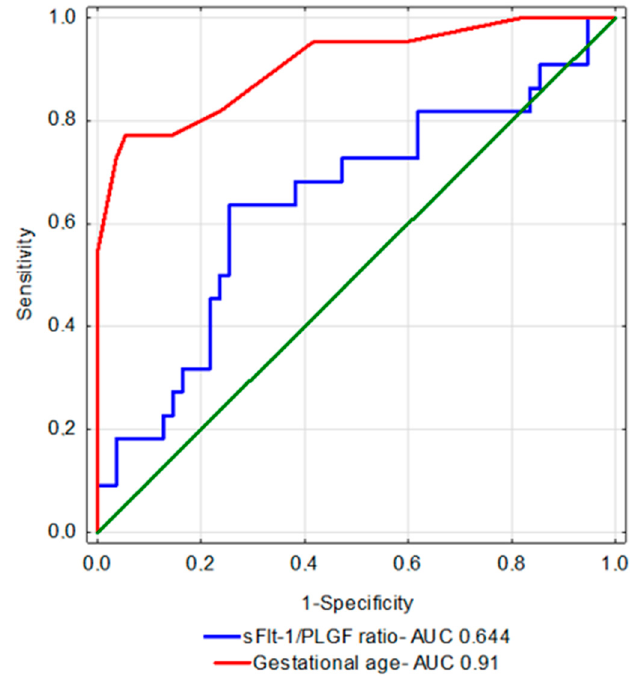
Figure 1. ROC curves for the selected parameters. Table 3 contains a comparison between the infants’ perinatal outcomes and the neo- natal complications for the birth week cut-off point defined using the ROC curve. Neo- nates with lower birth week values had higher sFlt-1/PlGF ratios. They also had worse Apgar scores. Moreover, their hospitalization times were longer and, in general, they were more frequently diagnosed with any of the above-listed adverse neonatal outcomes. In fact, for all of the listed complications these frequencies were statistically significantly higher. Only for necrotizing enterocolitis (NEC) was no statistical significance reached, which was probably the result of an insufficient size of the cohort. Table 3. Perinatal outcomes and neonatal complications depending on the birth week.